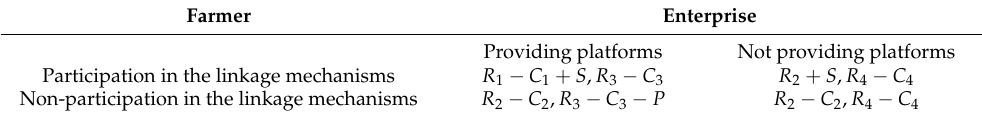
Table 5. Gamepayoffmatrixforthestrategyselectionoffarmersandenterpriseswithgovernmentintervention. Farmer